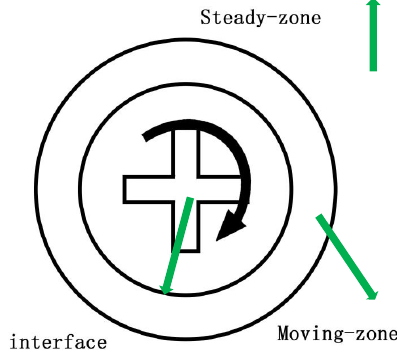
Figure 2. Multiple reference system model.